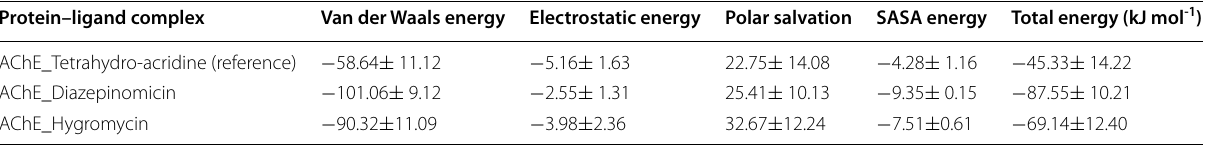
Table 5 Result showing the Van der Waals, electrostatic, polar salvation, SASA, and binding energy in kJ mol − 1 for the studied complexes Protein–ligand